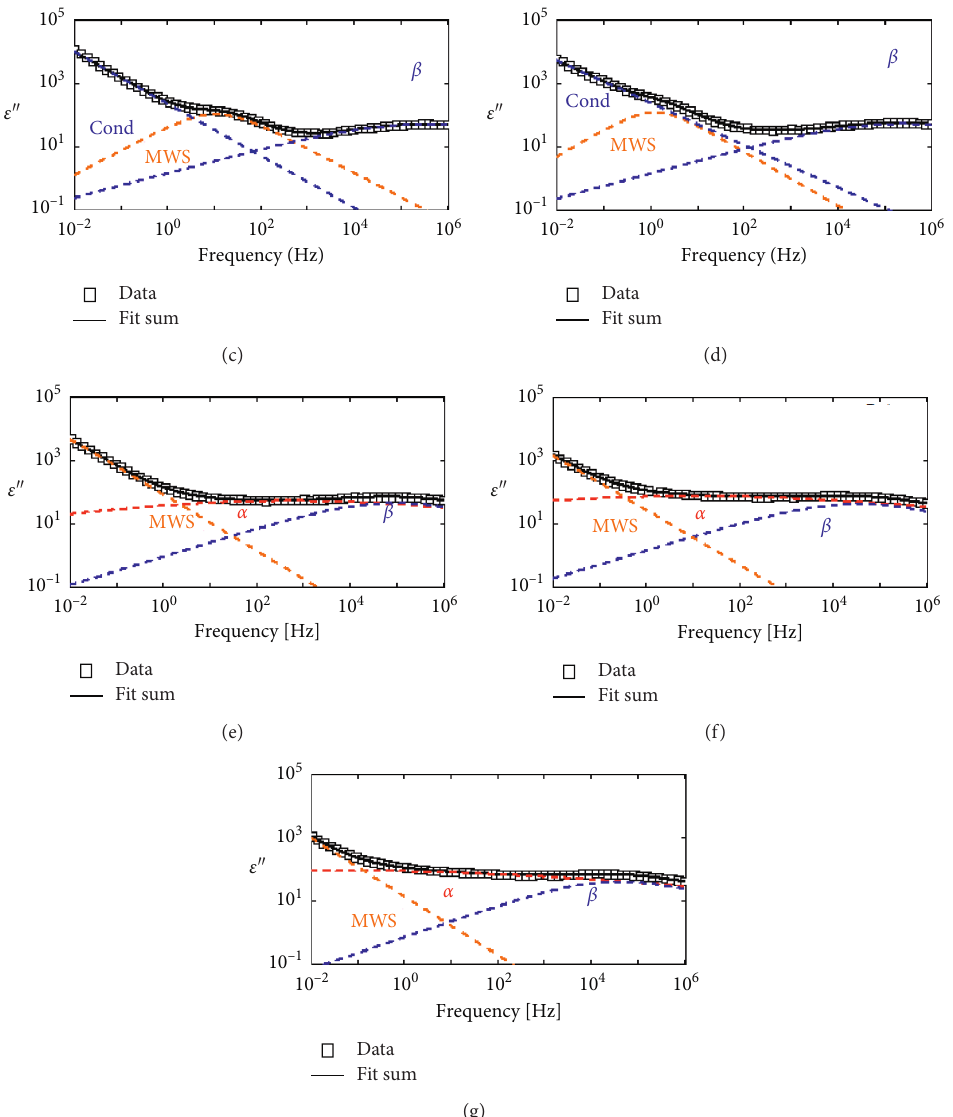
Figure 9: Relaxation processes of the EPDM specimen at seven temperatures ranging from 233K to 404K. Four relaxation processes, α (red dashed line), β (blue dashed line), MWS (orange dashed line), and conductivity (navy dashed line), contribute to the imaginary permittivity data. (a) 404K (b) 374K (c) 344K (d) 313 K (e) 281K (f) 257K, and (g)